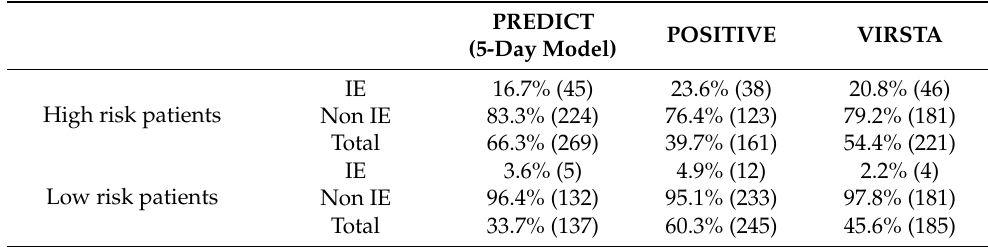
Table 2. IE and non-IE case distribution according to clinical prediction scores classification.